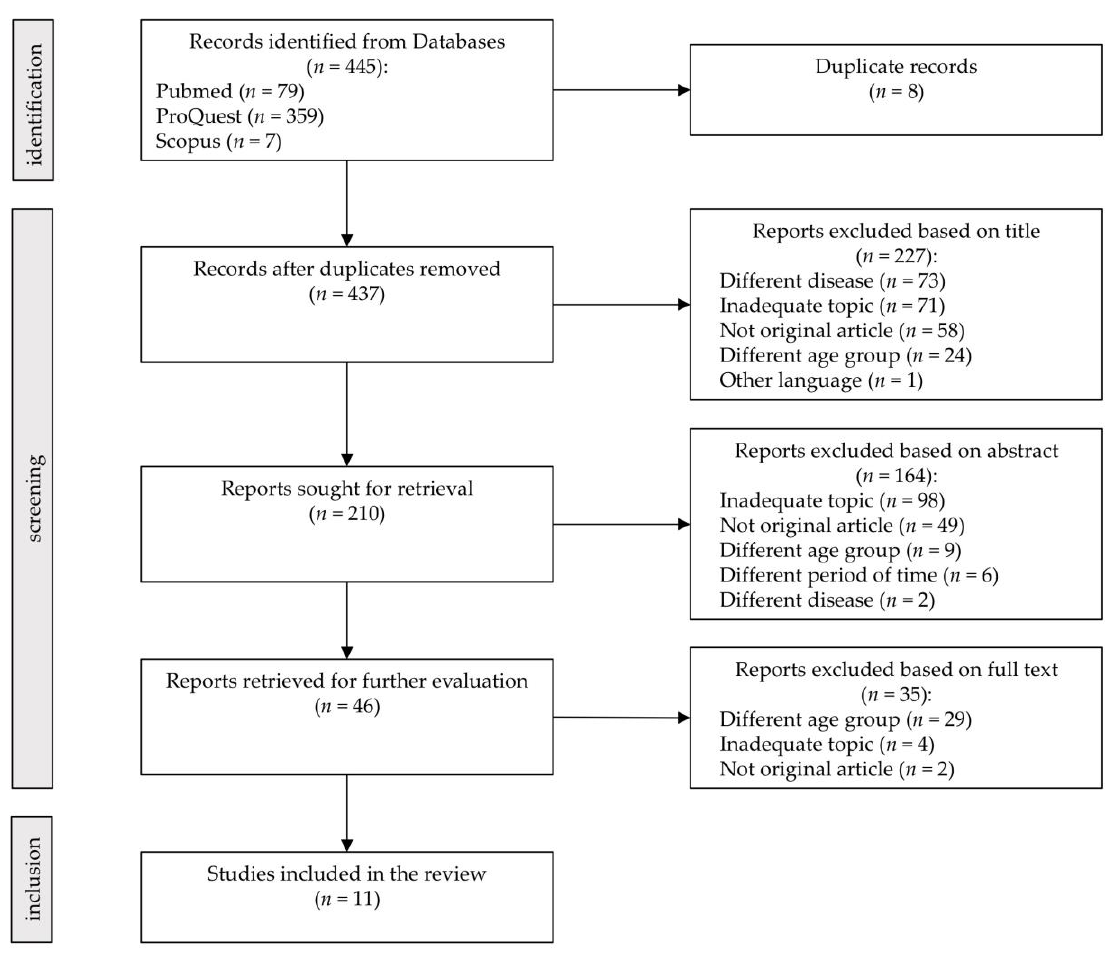
Figure 1. Study selection. The PRISMA 2020 statement [57].